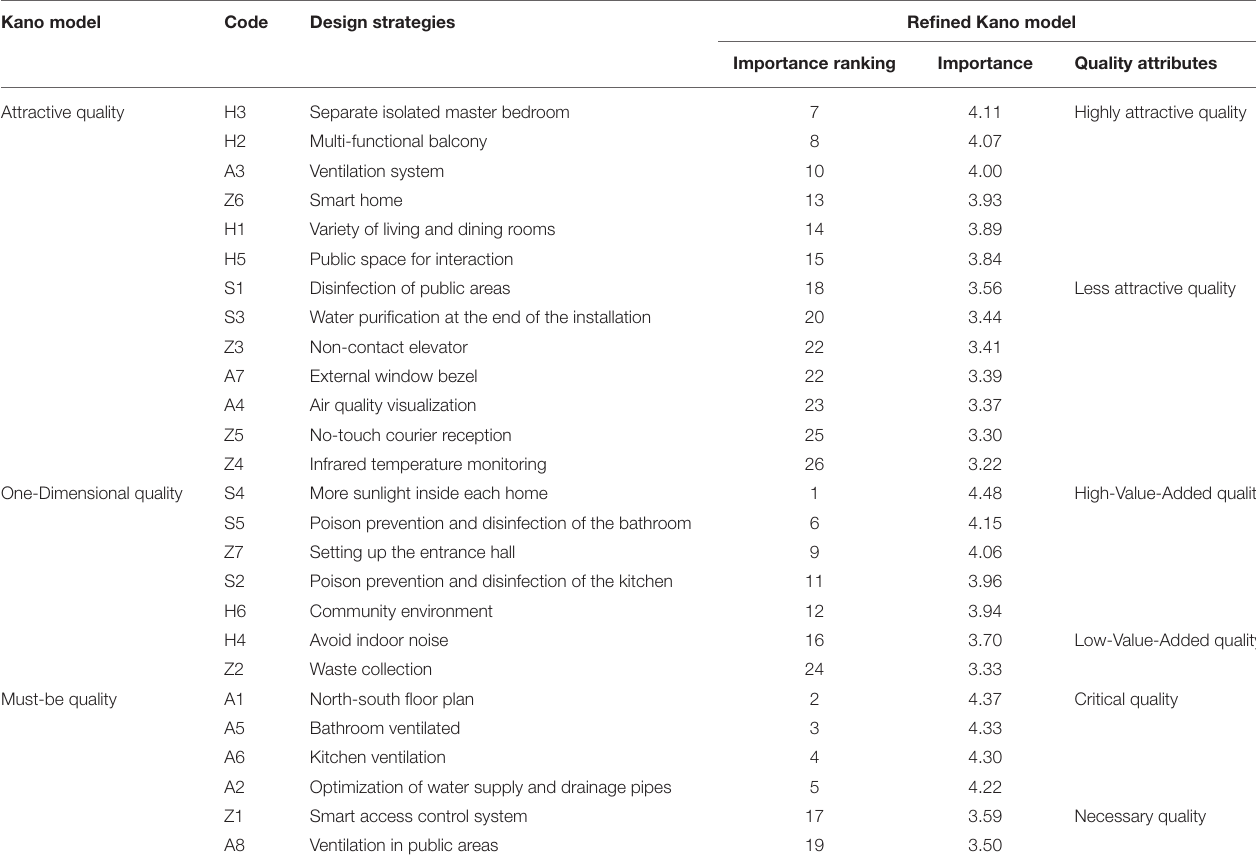
TABLE 5 | Result of the refined Kano